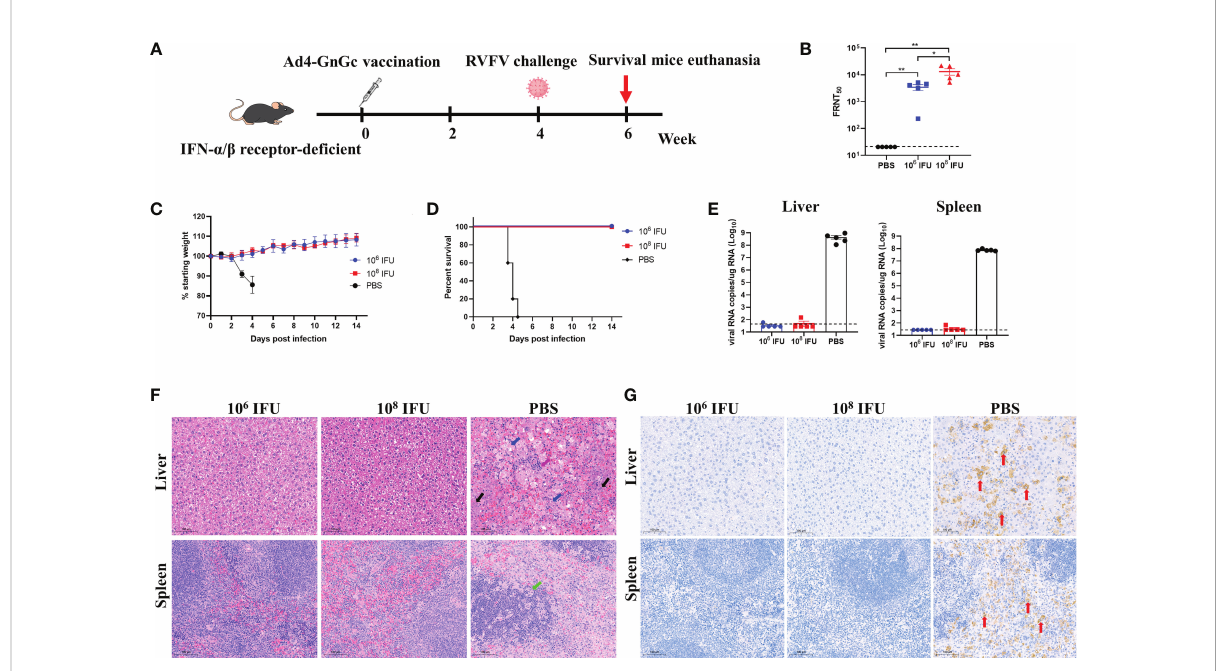
FIGURE 6 Protective effect of Ad4-GnGc against RVFV challenge in IFN receptor-de fi cient mice. Mice (n = 5) received one dose of 10 6 or 10 8 IFU of Ad4- GnGc or PBS via the intramuscular route. Four weeks after vaccination, the mice were challenged intraperitoneally with 2×10 4 TCID 50 of RVFV rMP-12 strain. The livers and spleens from PBS group (at the time of death) and vaccine-immunized groups (14 days after challenge) were collected and analyzed with viral RNA load, histopathological and immunohistochemical assays. (A) Schematic diagram of the immunization and challenge schedule. (B) Four weeks after vaccination (before virus challenge), serum neutralizing antibody titers were determined using infectious RVFV. (C) Mouse body weight change after RVFV challenge. (D) Mortality and survival curves of mice. (E) The viral loads in the liver and spleen following virus challenge were determined by qRT – PCR. (F) Representative histopathology (H&E) of livers and spleens from RVFV-infected mice. Hepatocyte steatosis is indicated by blue arrows; in fl ammatory cell in fi ltration is indicated by purple arrows; hepatocyte nuclear vacuolation and apoptosis are indicated by black arrows; splenic nodule atrophy is indicated by green arrows. Scale bar, 100 m m. (G) Representative immunohistochemical (IHC) staining of liver and spleen tissues with RVFV Gn-speci fi c monoclonal antibodies. Red arrows indicate RVFV-positive signals. Scale bar, 100 m m. Data are shown as the mean ± SEM. P values were calculated by one-way ANOVA with multiple comparison tests. * P < 0.05, ** P <